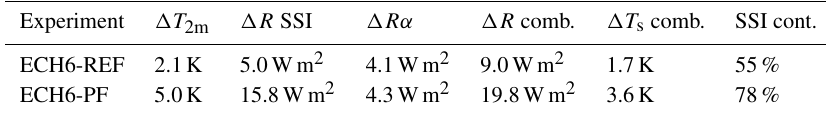
Table 1. Summer (JJA) biases over the six largest Arctic rivers for 2m temperature ( T 2m , to WFDEI), and radiative flux ( R ) into the surface due to biases in SSI (to CERES), albedo ( α , to GlobAlbedo), and their combined effect (comb.) as well as the estimated related impact on surface temperature ( T s ) and the contribution of the SSI bias to this impact.